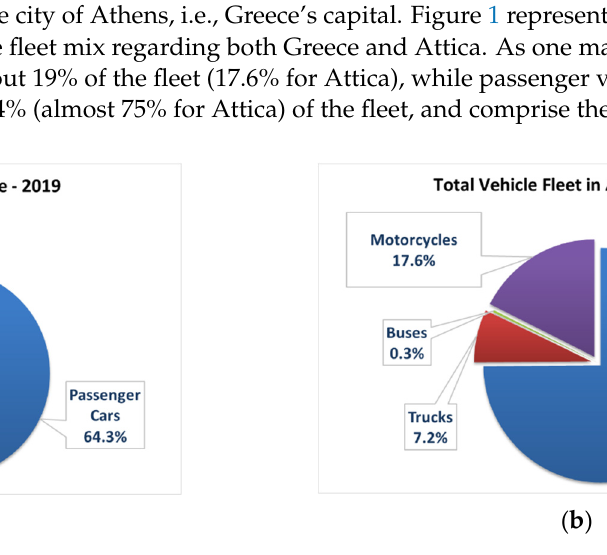
Figure 2. Overall fleet of circulating vehicles in Greece and in Attica, for time-period 2002 to 2019. Finally, as it derives from Figure 3, it appears that in recent years, the regional share of passenger vehicles in Greece has remained almost constant. In particular, Attica’s pas- senger vehicle fleet clearly had the largest share. More specifically, the category of pas- senger vehicles constituted 73.9% of the total number in Attica, 53.5% of the total number of passenger vehicles in the country and 34.4% of the total number of all country’s vehi- cles. Therefore, and because passenger vehicles hold the largest share, it is this category this study focuses on. At the same time, it is clear that any changes in the use of passenger vehicles that takes place in Attica, essentially affects most of the fleet throughout the coun- try.